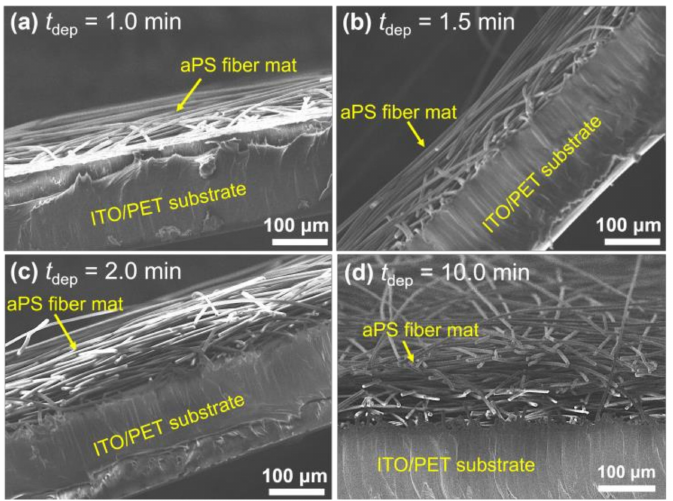
Figure 13. Cross-sectional FESEM images of the as-electrospun aPS fiber mats produced with V ES = 11.0 kV and different t dep : ( a ) 1.0, ( b ) 1.5, ( c ) 2.0 and ( d ) 10.0